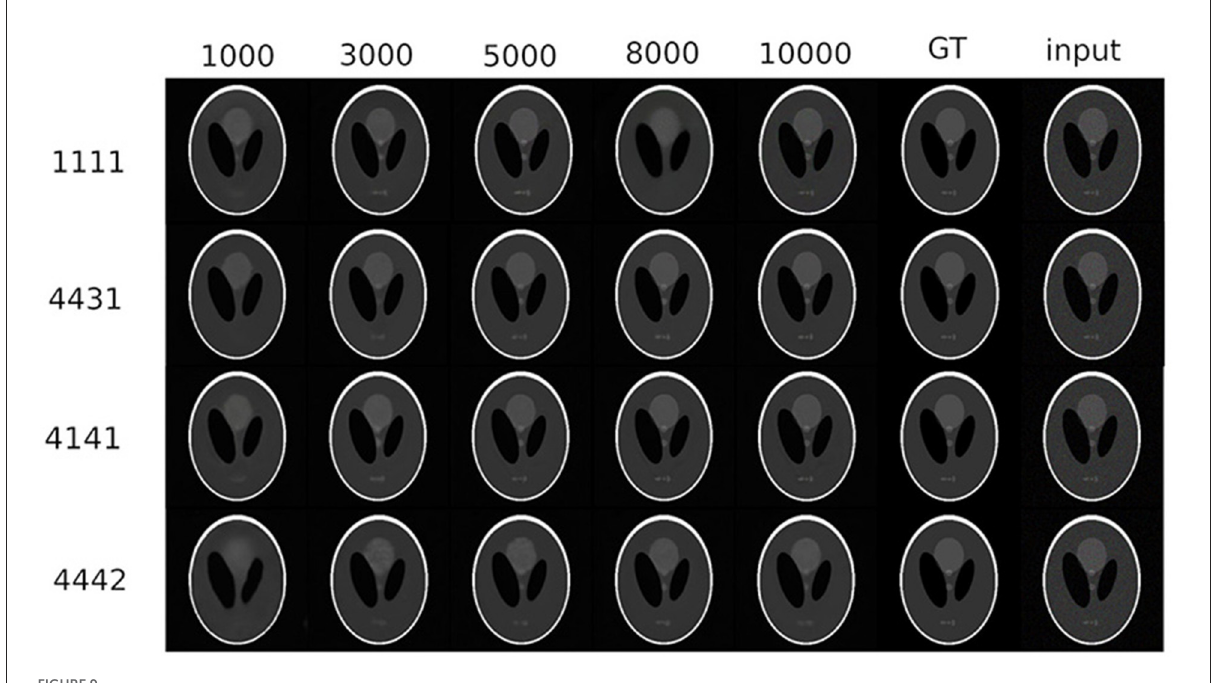
FIGURE9 Phantom experiments in the version 256